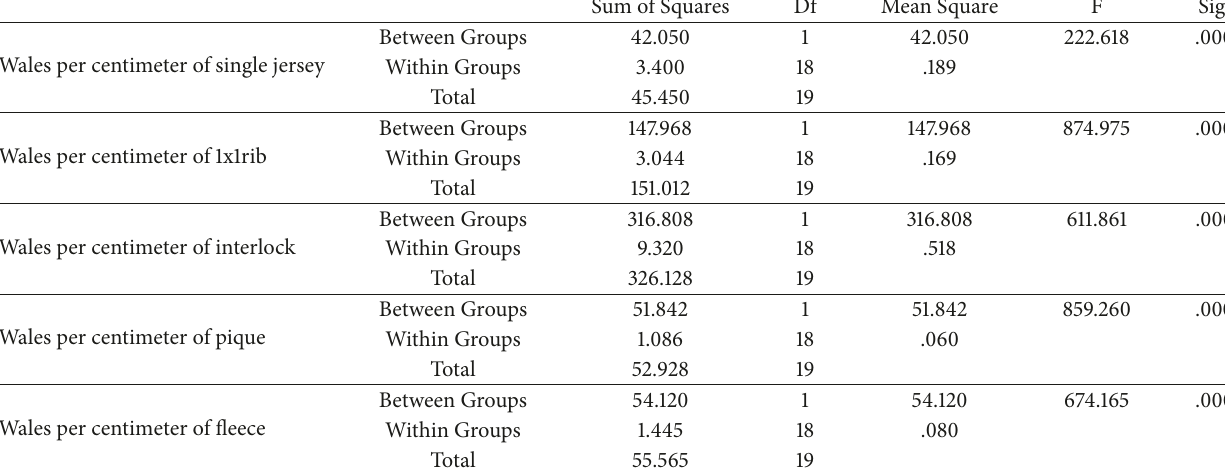
Table 5: Analysis of variances of knitted fabrics wpc made from 100% cotton and cotton/elastane yarns. Sum of Squares